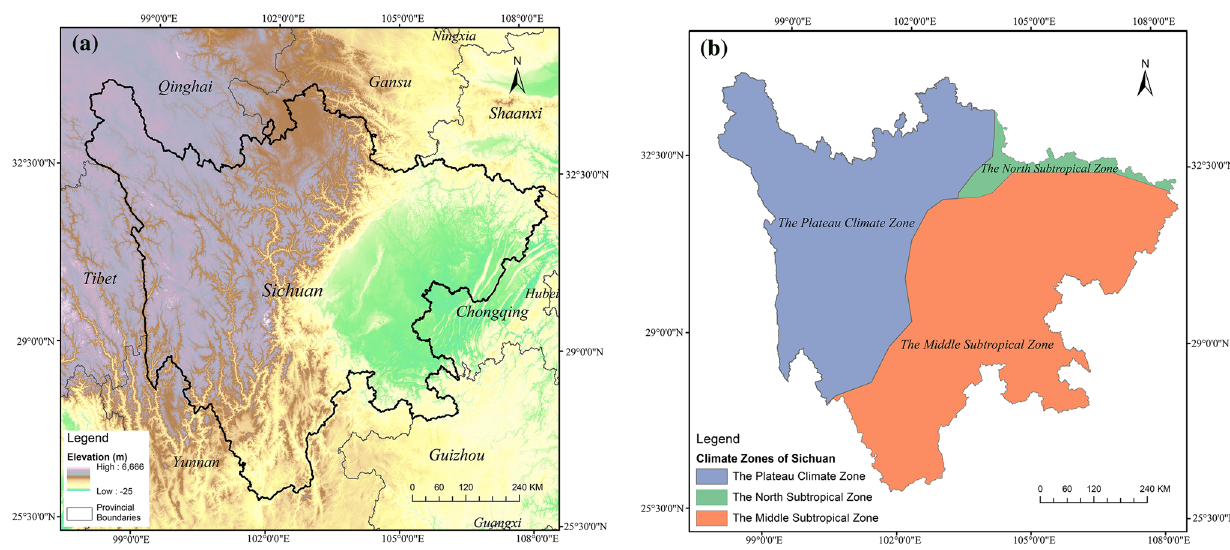
Fig. 1 The study area of Sichuan Province. a Elevation; b distribution of climate types in Sichuan Province. Source Adapted from the climate zone of China provided by the Data Center for Resources and Environmental Sciences, Chinese Academy of Sciences (RESDC) (http://www. resdc.cn)